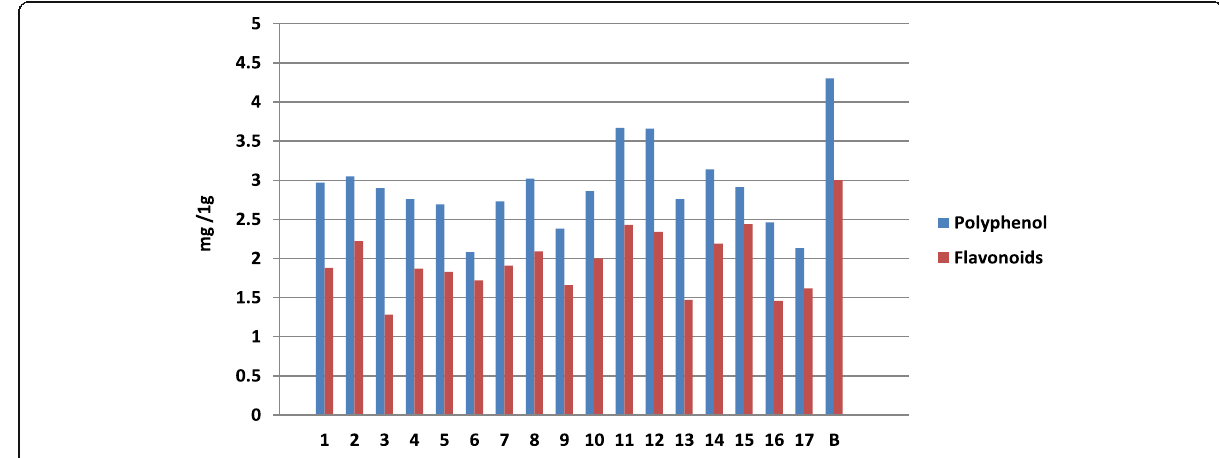
Fig. 2 The polyphenolic and flavonoids content in samples, 1 – 17 and blank